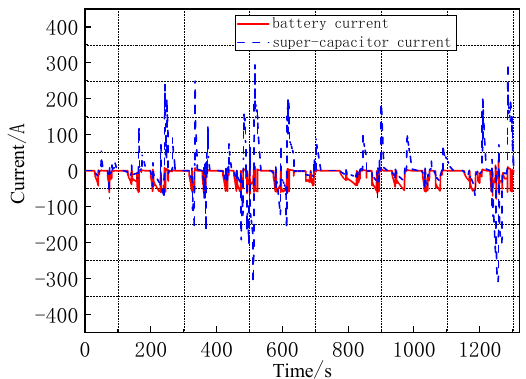
Figure 14. Power when battery is powered alone.